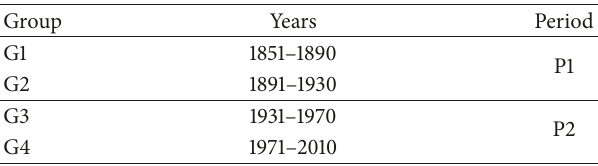
Table 1: Groups and periods used during the analysis of 20CRv2c (EM and 56 members of the ensemble).